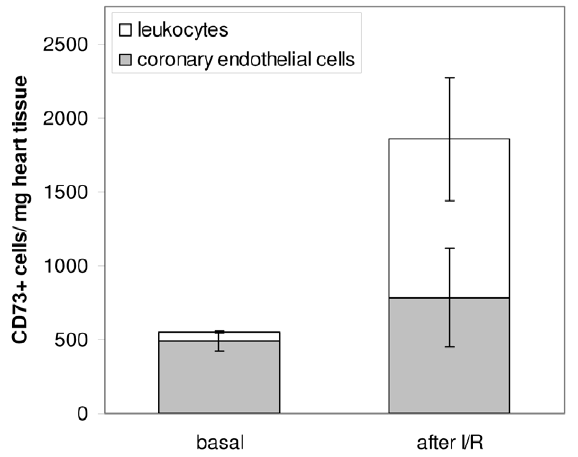
Figure 6. Comparison of cardiac CD73 + leukocytes and coronary endothelial cells under basal conditions and after I/R. Values are calculated from data given in Table 1. Values are means 6 SEM of n=5 experiments.